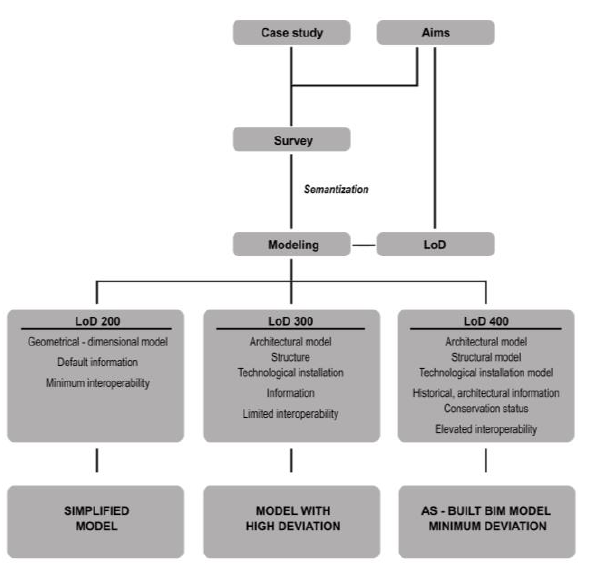
Figure 3. Framework of the BIM process for the architectural heritage and its development.